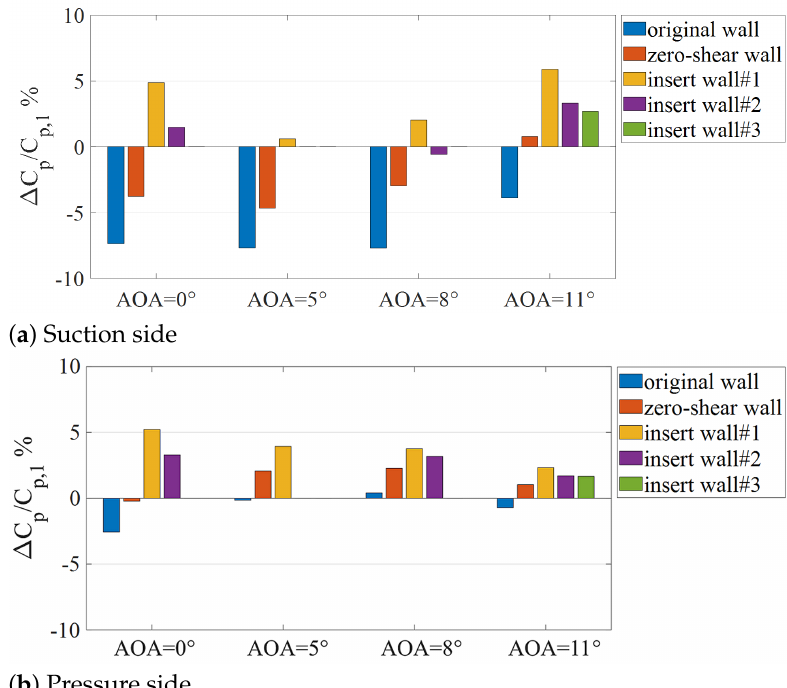
Figure 15. Deviation of C p at x / C = 0.5 between free-flight and experimental conditions, for ( a ) suction and ( b ) pressure sides, using various